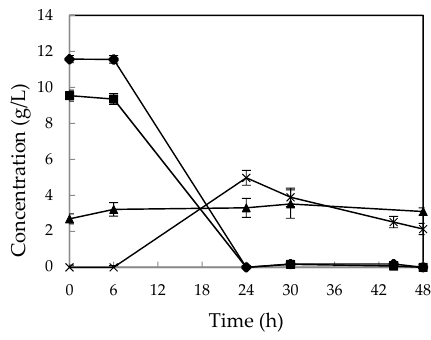
Figure 4. Concentration of ( ▲ ) sucrose, ( ♦ ) glucose, ( ■ ) fructose, and (×) ethanol in the cultivation of CWFS supplemented with all required nutrients in a 4-L airlift bioreactor using M. indicus . Data are means ± SD, n = 2.